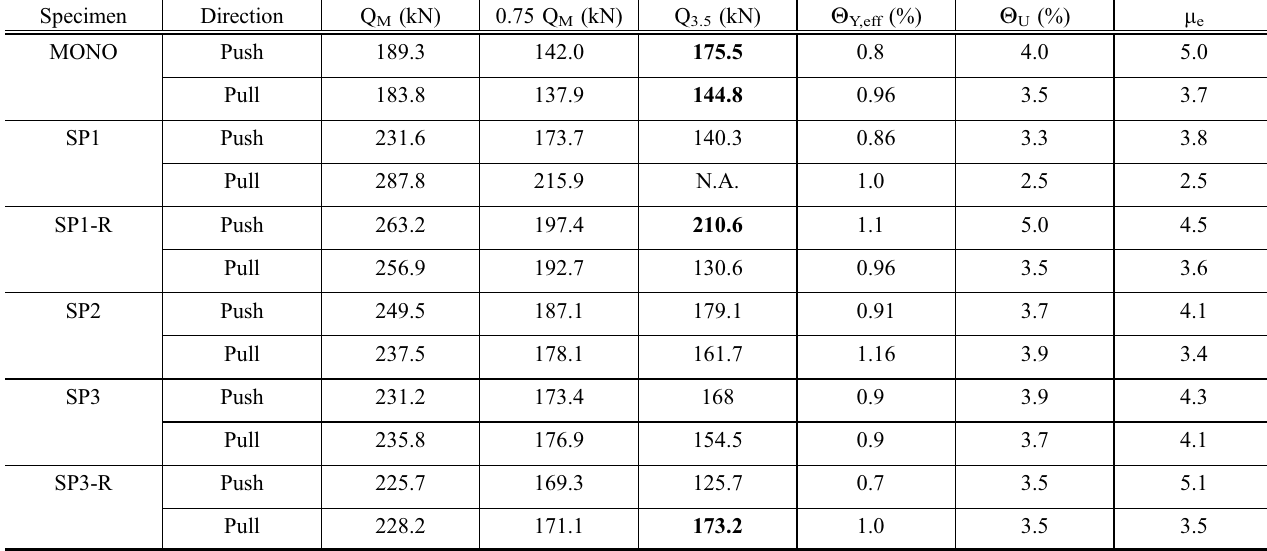
Table 4 Lateral strength and ductility of test